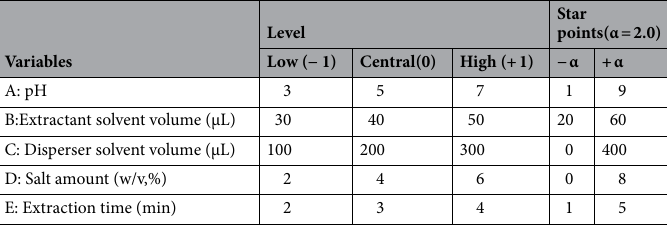
Table 1. The matrix of central composite design and